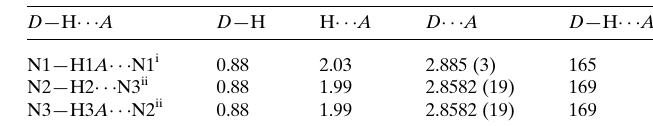
Table 1 Hydrogen-bond geometry (A˚ , (cid:5) ).